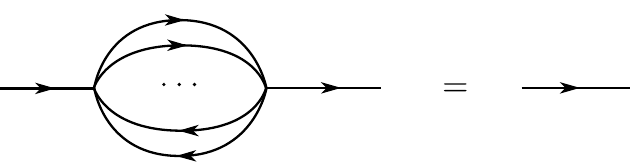
Figure 1 . Schwinder-Dyson equation for the two-point function. Black line stands for the full conformal